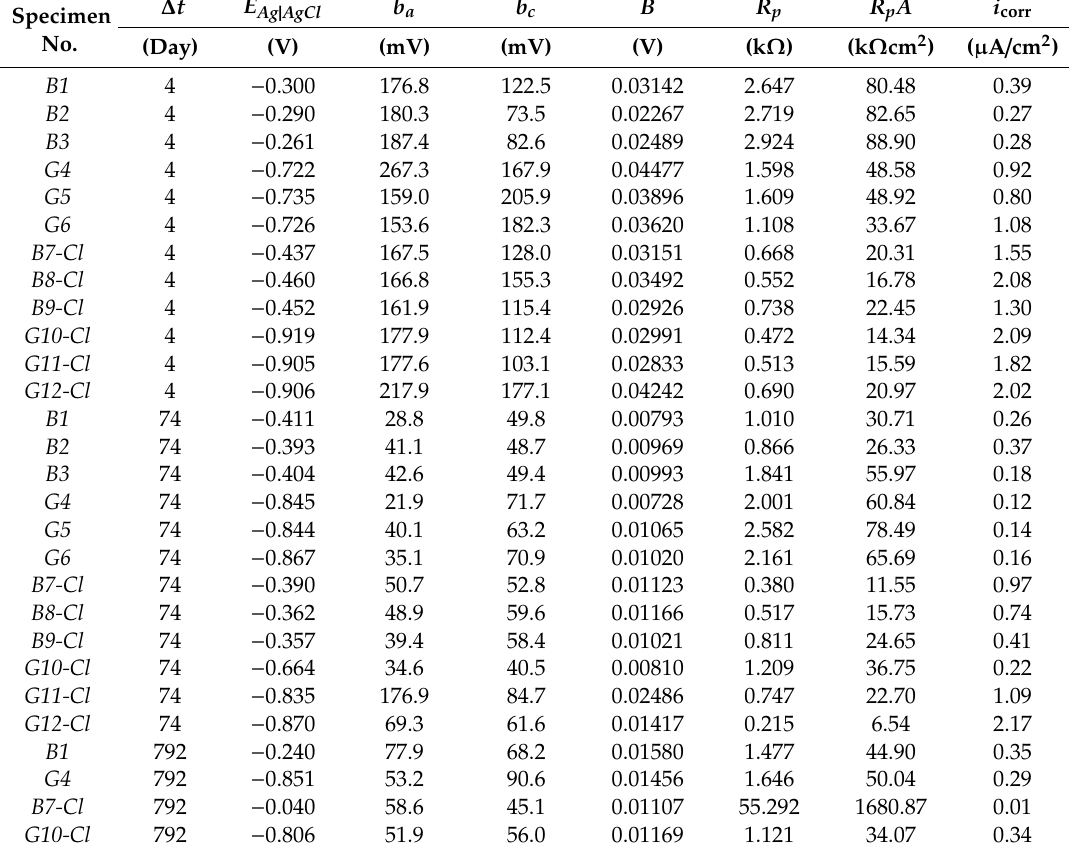
Table A1. Comparison of results from analyzing polarization curves of reinforcing steel in concrete, obtained for three selected measuring series on day 4, 74, and